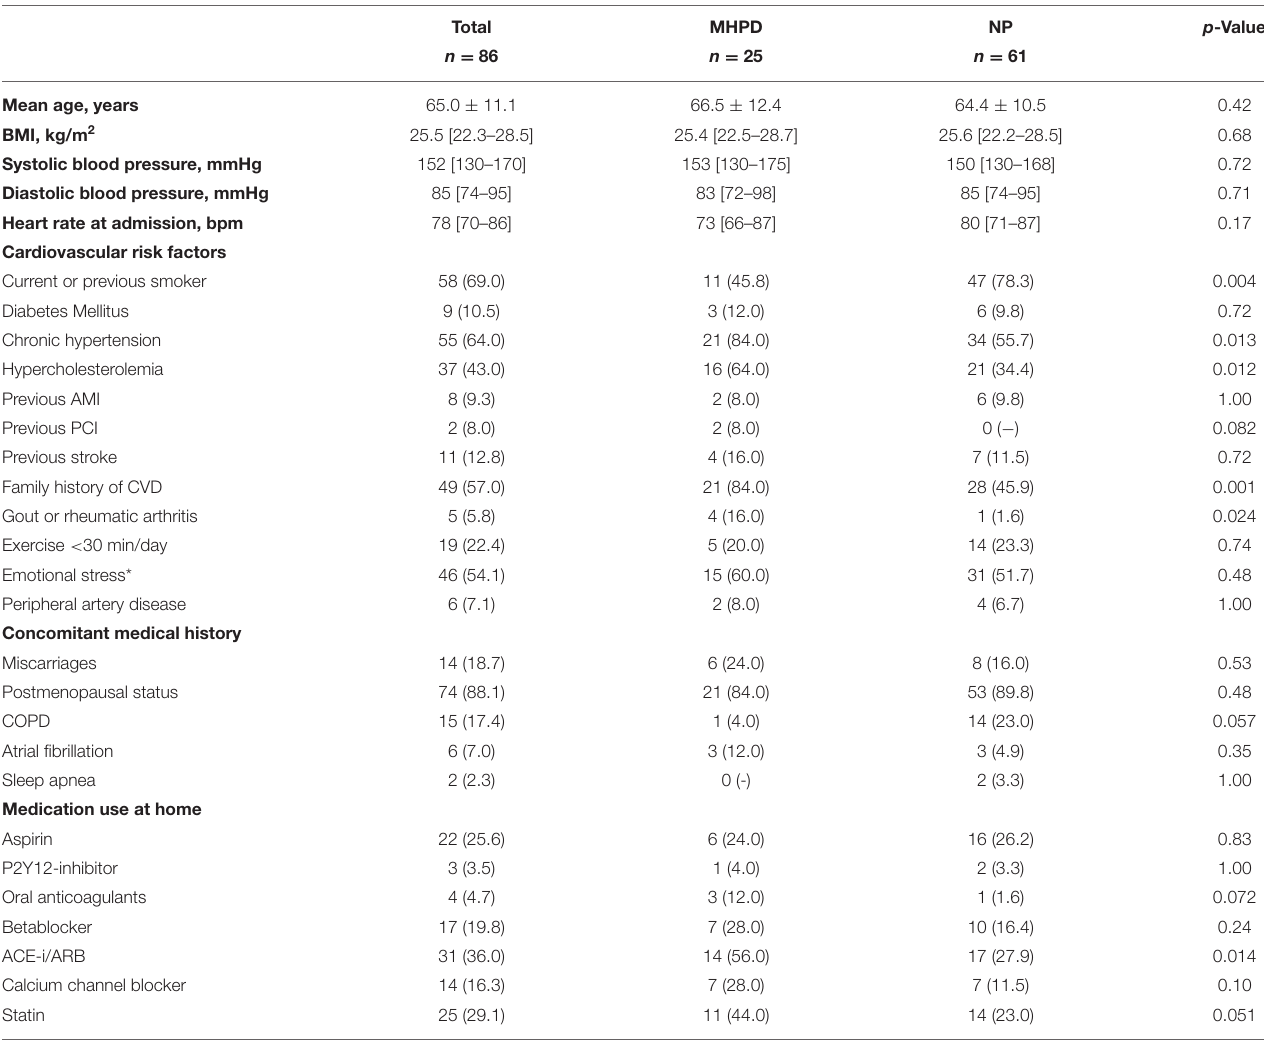
TABLE 2 | Baseline